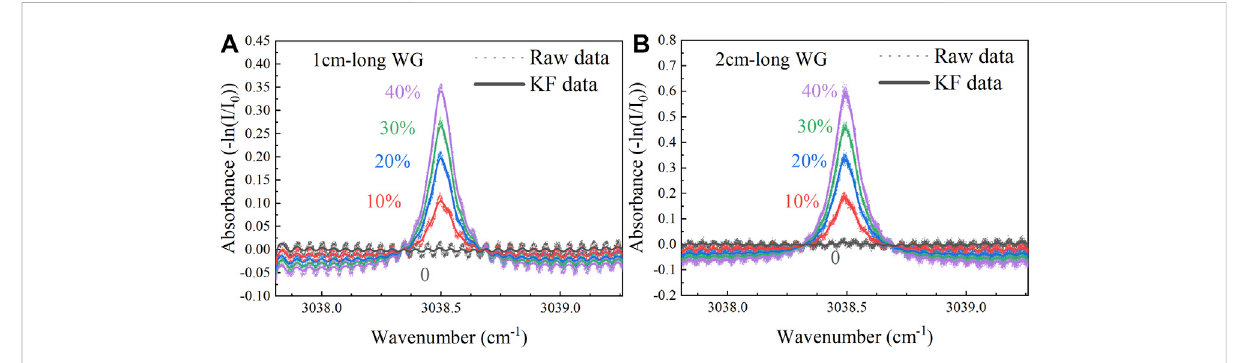
FIGURE 3 (A) Absorbanceofthe1 cm-longwaveguideunderdifferentCH 4 concentrationlevelsof0,10,20,30and40%. (B) Absorbanceofthe2 cm-long waveguide under different CH 4 concentration levels of 0, 10, 20, 30 and 40%.